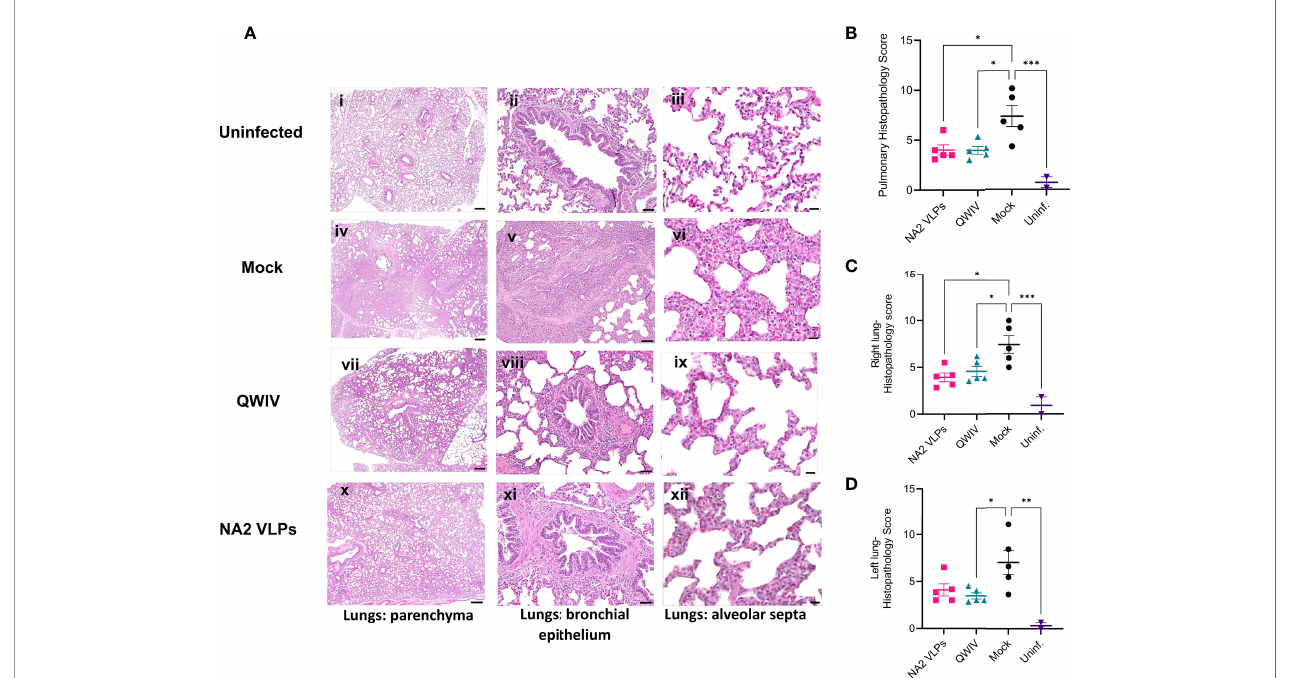
FIGURE 7 | Vaccination with NA2 VLPs and the commercially available swine QWIV reduces total histopathology scores in pig lungs post-infection. Lung tissues were collected at necropsy 5 days post-infection and fi xed in formalin. Five µm sections were stained with H&E and examined by light microscopy. Lung sections were scored by a board-certi fi ed veterinary pathologist. (A) H&E-stained representative lung tissue sections from each respective experimental group. Parenchyma 500 m m scale bar (2x magni fi cation), bronchial epithelium 50 m m scale bar (20x magni fi cation); alveolar septa 20 m m scale bar (40x magni fi cation). (B) Mean lung histopathology scores from each vaccinated group. (C) Right lung mean histopathology scores. (D) Left lung mean histopathology scores. Pink Squares represent the NA2 VLP vaccinated pigs, cyan triangles the QWIV vaccinated pigs, black circles the mock vaccinated pigs and magenta triangles healthy uninfected pigs. Error bars represent SEM. Statistical analysis was performed by one-way ANOVA test. * = p < 0.05; ** = p < 0.01; *** = p <